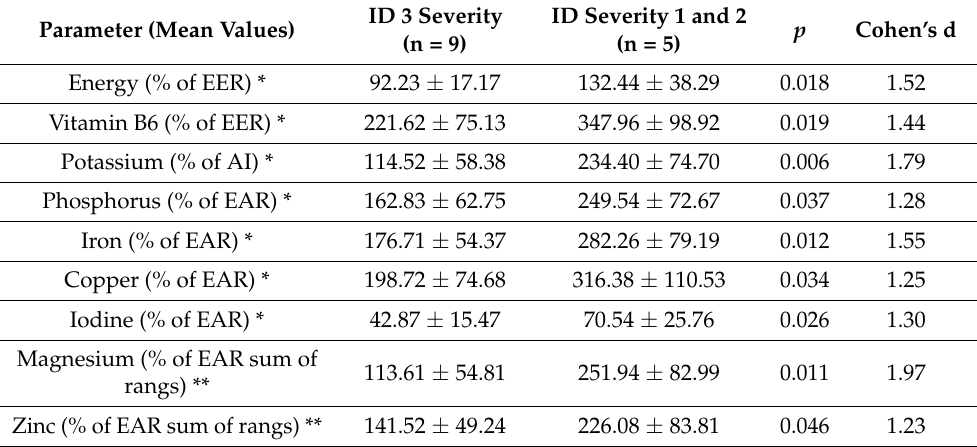
Table 7. Comparison of the energy and nutrients intake (in terms of the norm realization) in groups distinguished according to the severity of ID (differences statistically significant excluding fats and carbohydrates). Data Shown as mean ±